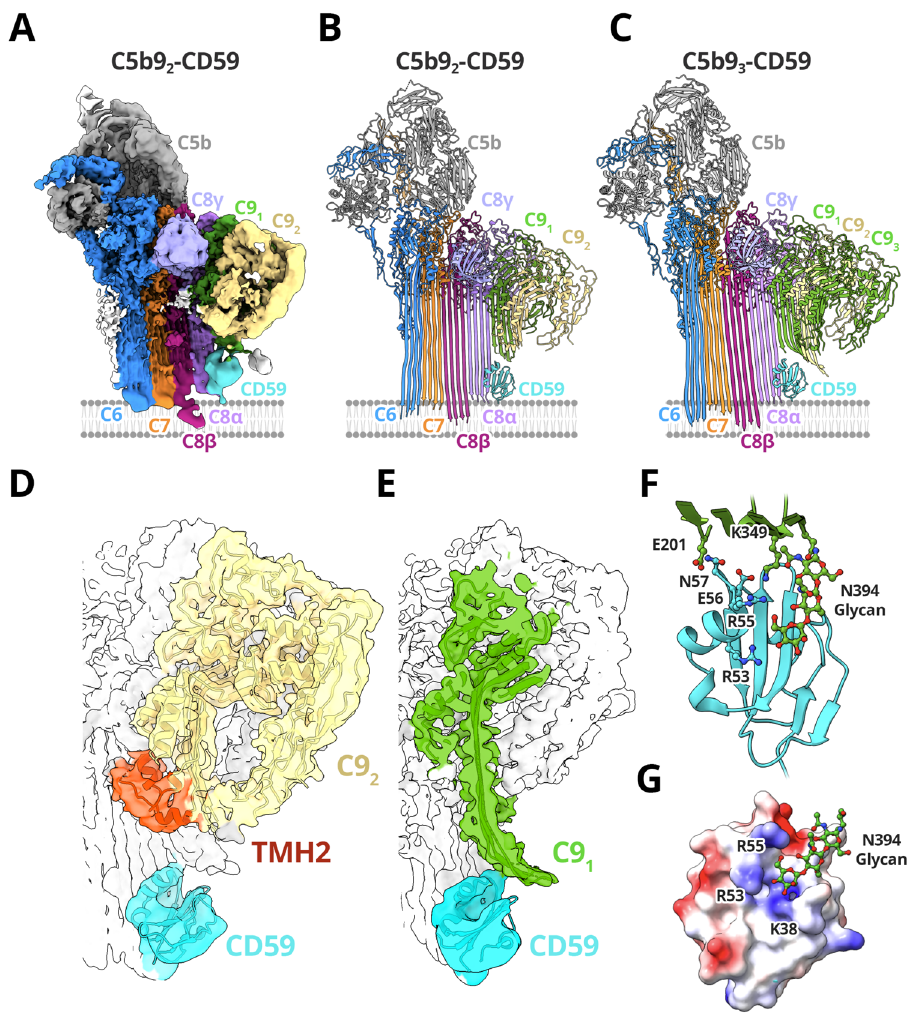
Fig. 4 | Structure of the C5b9-CD59 complex. CryoEM map A and model B of C5b9-CD59complexes comprised of 2 molecules ofC9 (C9 1 and C9 2 ).( C ) A model for the C5b9-CD59 complex comprised of 3 C9 molecules. Complement proteins are colored (C5b, grey; C6, blue; C7, orange; C8 α pink, C8 β magenta, C8 γ light purple); CD59 is cyan. The membrane, not visible in the sharpened map, is sche- matized for reference. D , E Density for the C5b9 2 -CD59 map after density sub- traction and focused re fi nement (transparent surface) overlayed with the model. D For the terminal C9 (C9 2 , yellow), only the fi rst transmembrane β -hairpin has